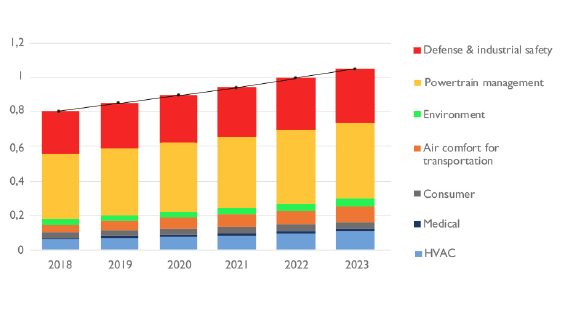
Figure 1. 2018-2023 Gas Sensor Market in Value($B) [12].